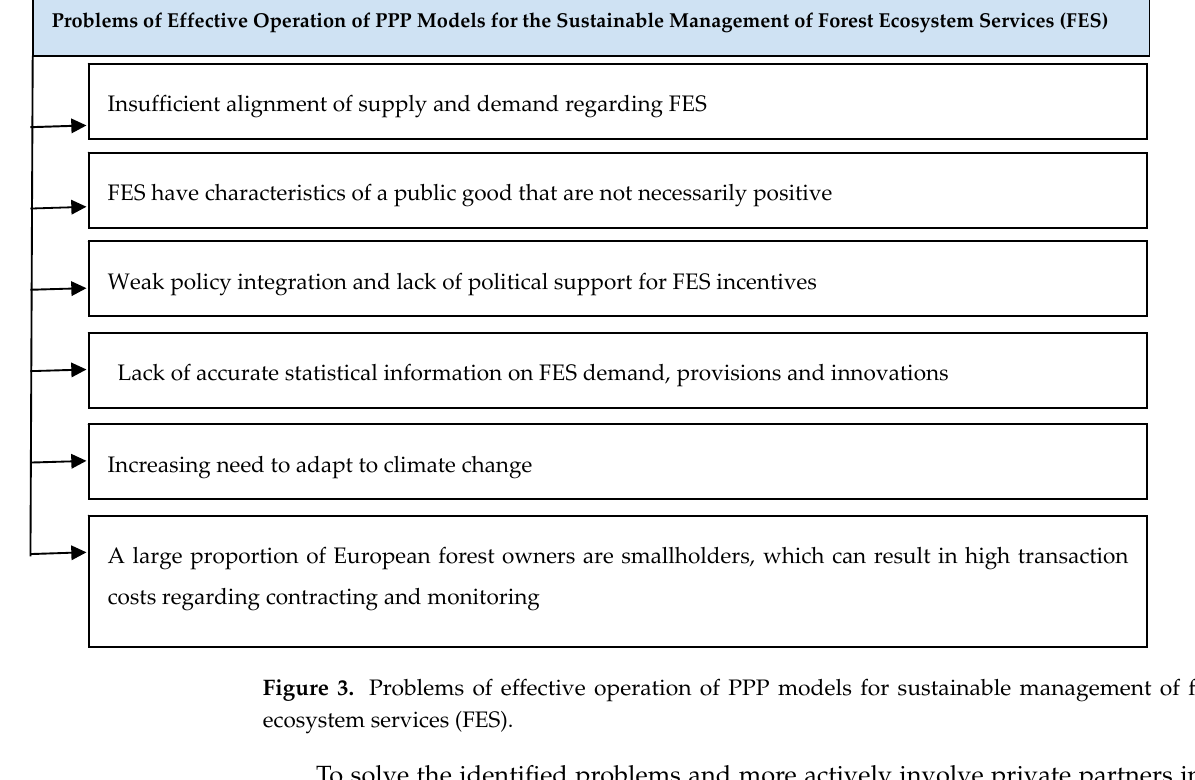
Figure 3. Problems of effective operation of PPP models for sustainable management of forest ecosystem services (FES) .